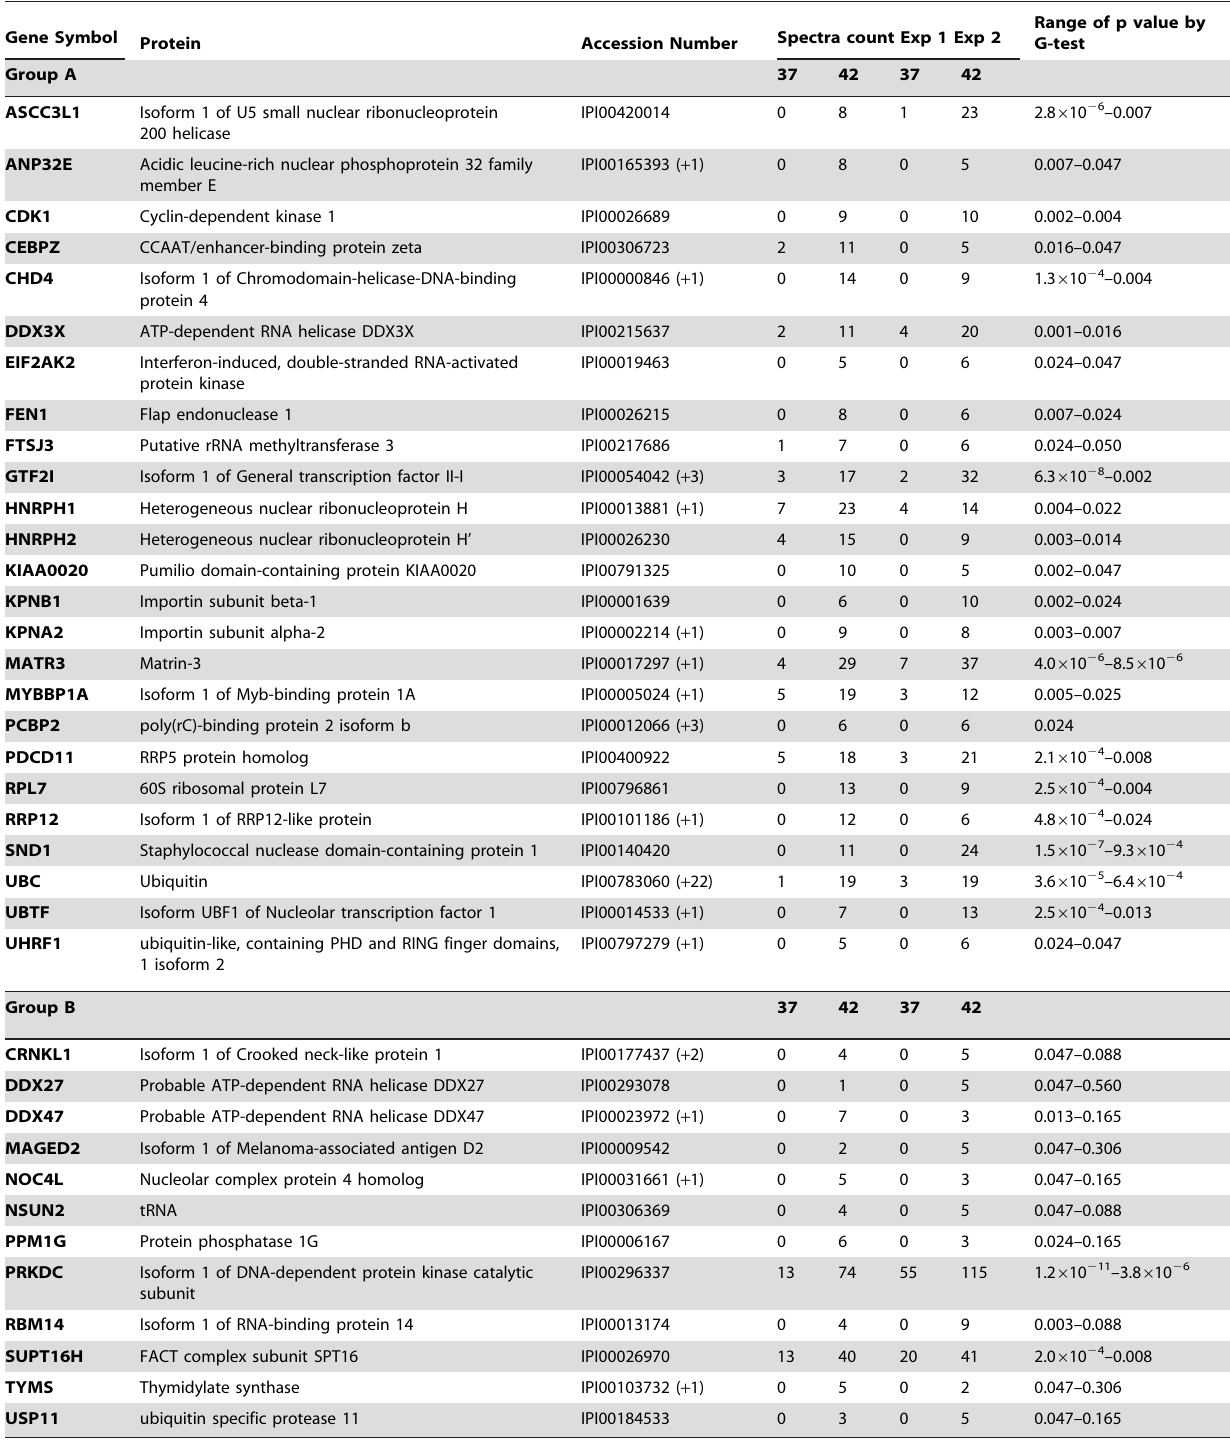
Table 1. Insoluble proteins in SH-SY5Y cells identified after 42 u C heat-shock treatment.